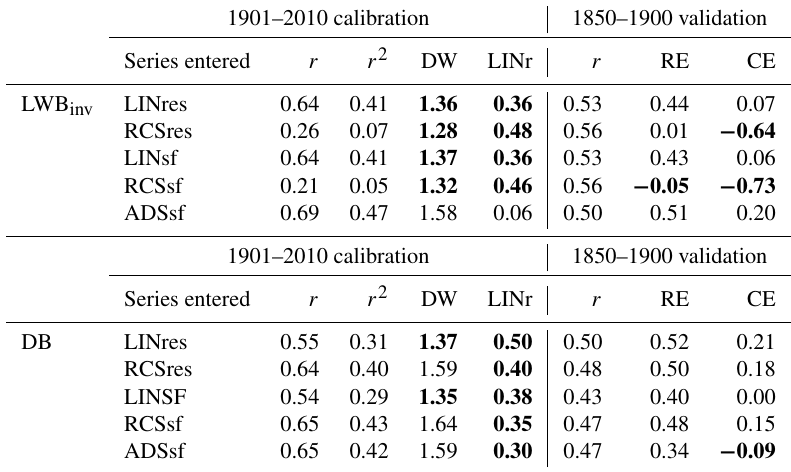
Table 5. Extended reconstruction calibration experiments using different chronology versions (Fig. 6) of LWB inv and DB. Results in bold font do not pass